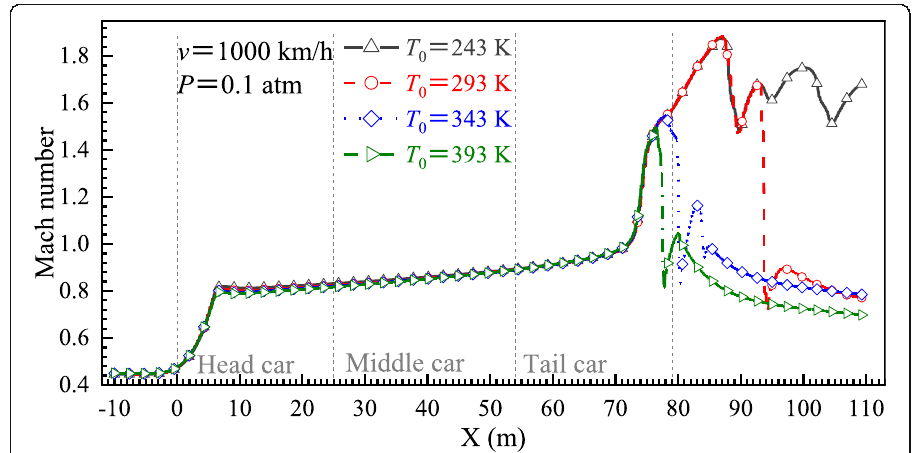
Fig. 16 Mach number along the top of the tube wall at different T 0 : x -coordinate ranges from − 10 m